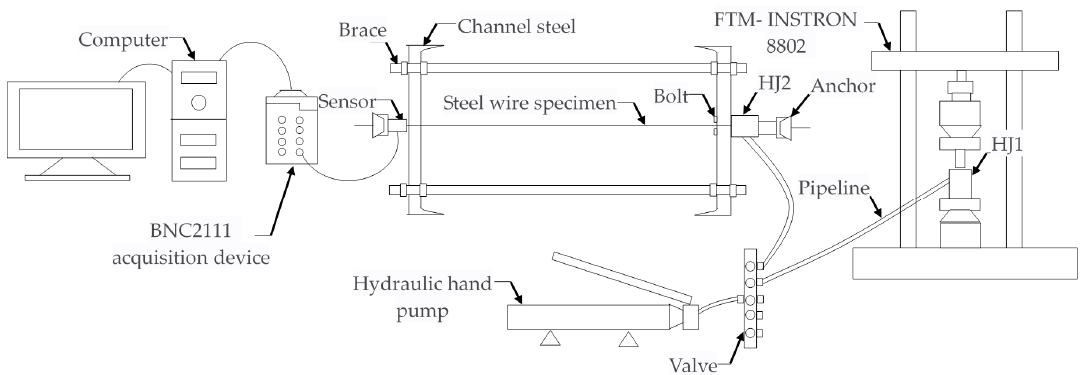
Figure 3. Schematic diagram of loading device.